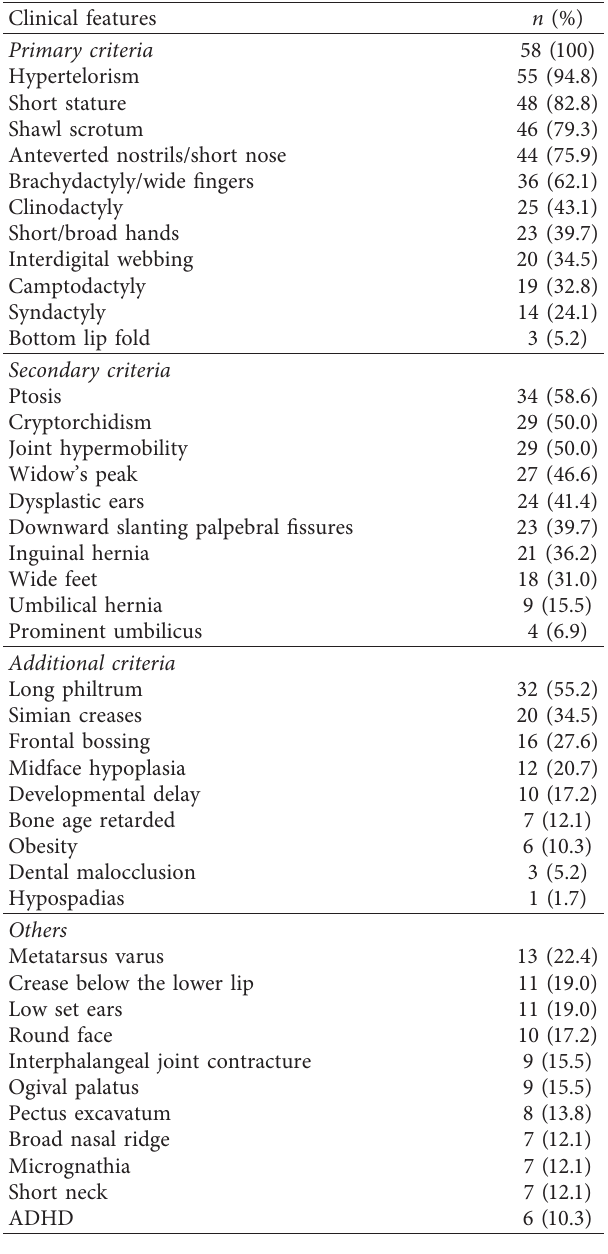
Table 2: Prevalence of clinical features segregated into categories according to the